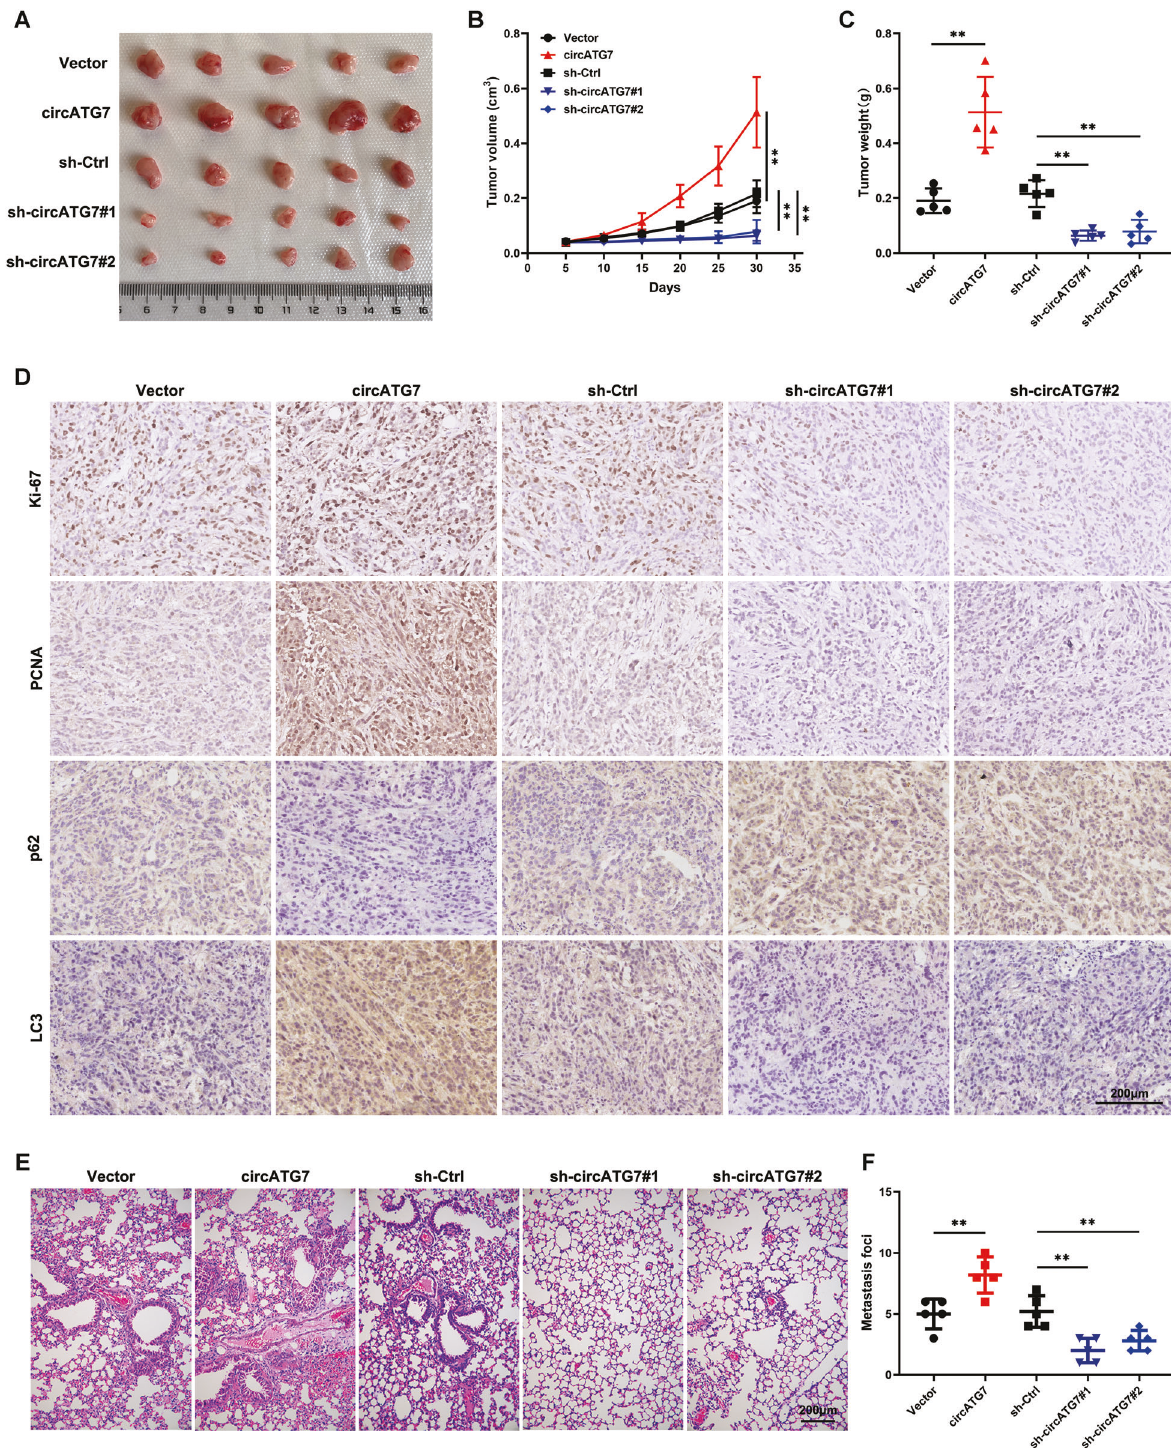
Fig. 8 CircATG7 promoted the proliferation, motility, and autophagy of PC cells in vivo. A , B The rate of proliferation in tissues with circATG7 overexpression and circATG7 knockdown. C The weight of tumor tissues with circATG7 overexpression and circATG7 knockdown. D The expression of PCNA, KI67, P62, and LC3 was determined in tumor tissues with circATG7 overexpression and circATG7 knockdown using immunohistochemical staining. E , F A metastatic lung model was used to detect the metastatic ability of PANC-1 cells with circATG7 overexpression and circATG7 knockdown. ** P <